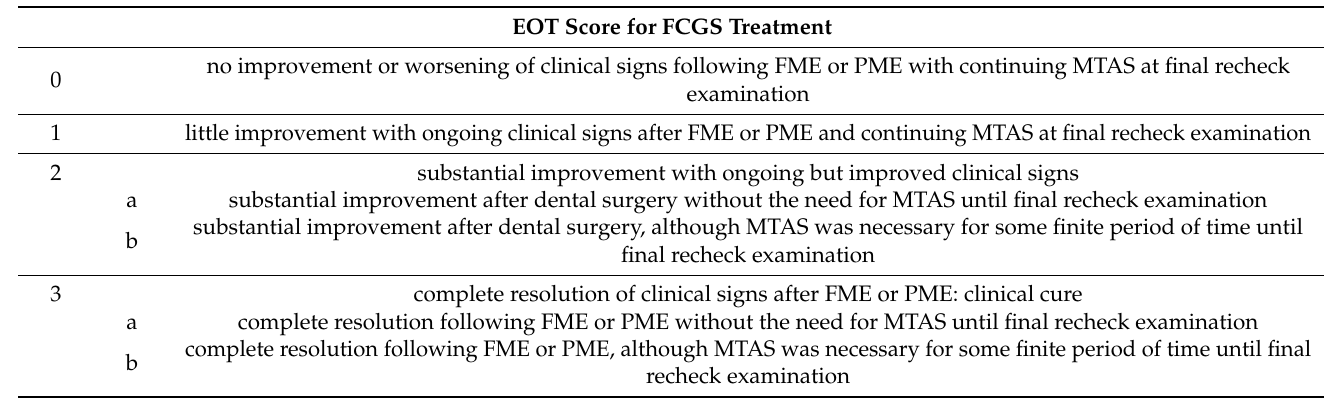
Table 1. EOT score for FCGS surgical